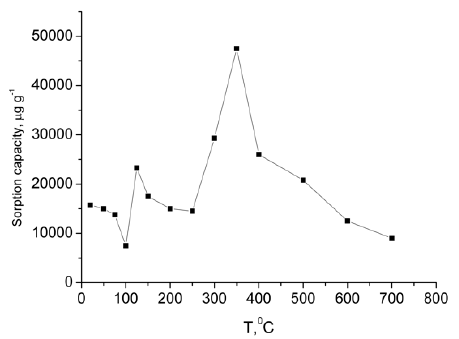
Figure 4. Dependence of the sorption capacity of clinoptilolite towards praseodymium(III) on thermal treatment.